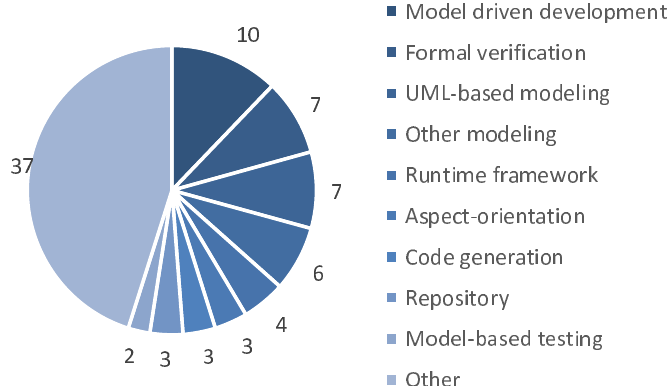
Figure 5. Breakdown of tools and automation (adopted from [247] with updates of